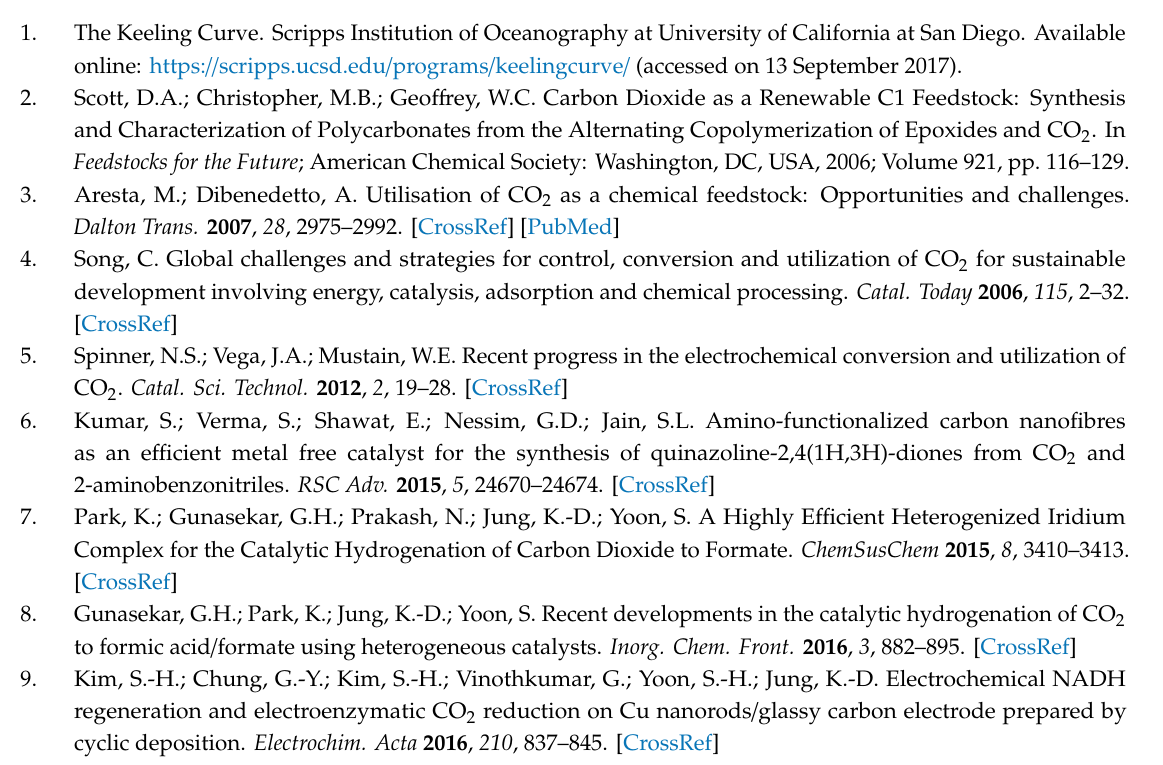
Figure S1: PXRD pattern of std-ZnGA and PXRD pattern calculated from the crystal structure of ZnGA via Mercury 3.7, Figure S2: (a) FT-IR spectra of std-ZnGA and ZnGA-M catalysts, (b) PXRD patterns of std-ZnGA and ZnGA-M catalysts, Figure S3: SEM images of std-ZnGA and ZnGA-MCl n , Figure S4: STEM image and EDS mapping. (a) STEM image of ZnGA-Al-1; STEM-EDS mapping of (b) Zn (red)and (c) Al (green) elements in ZnGA-Al-1; (Scale bar: = 200 nm), Figure S5: FT-IR spectra of std-ZnGA and ZnGA-Al-1, Figure S6: Expected Table 1, Figure S8: 13 C NMR spectrum of PPC from entry 3 in Table 1, Figure S9: GPC elugrams for some selected polymers from Table 1, Figure S10: DSC curves of selected polymers from Table